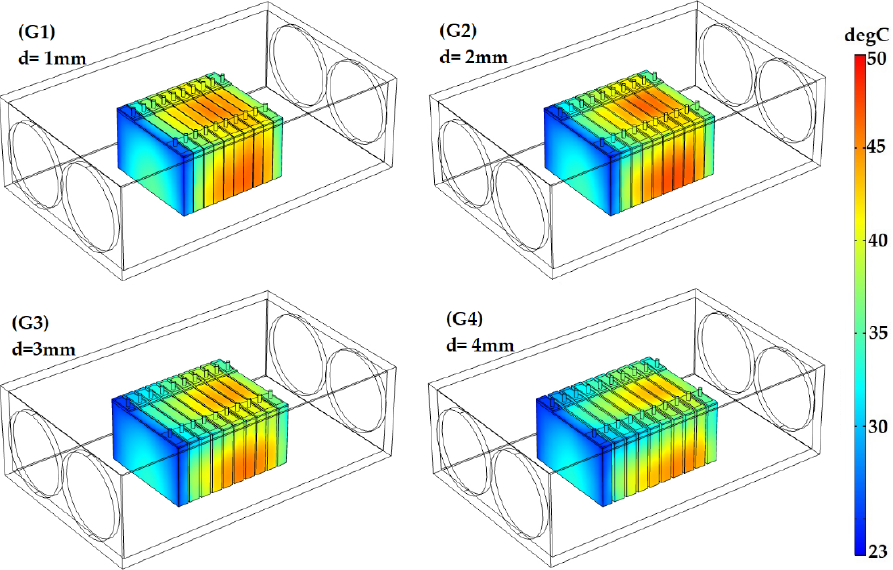
Figure 13. Temperature distribution of the LiC module for various gap spacings between the neigh- boring LiCs.